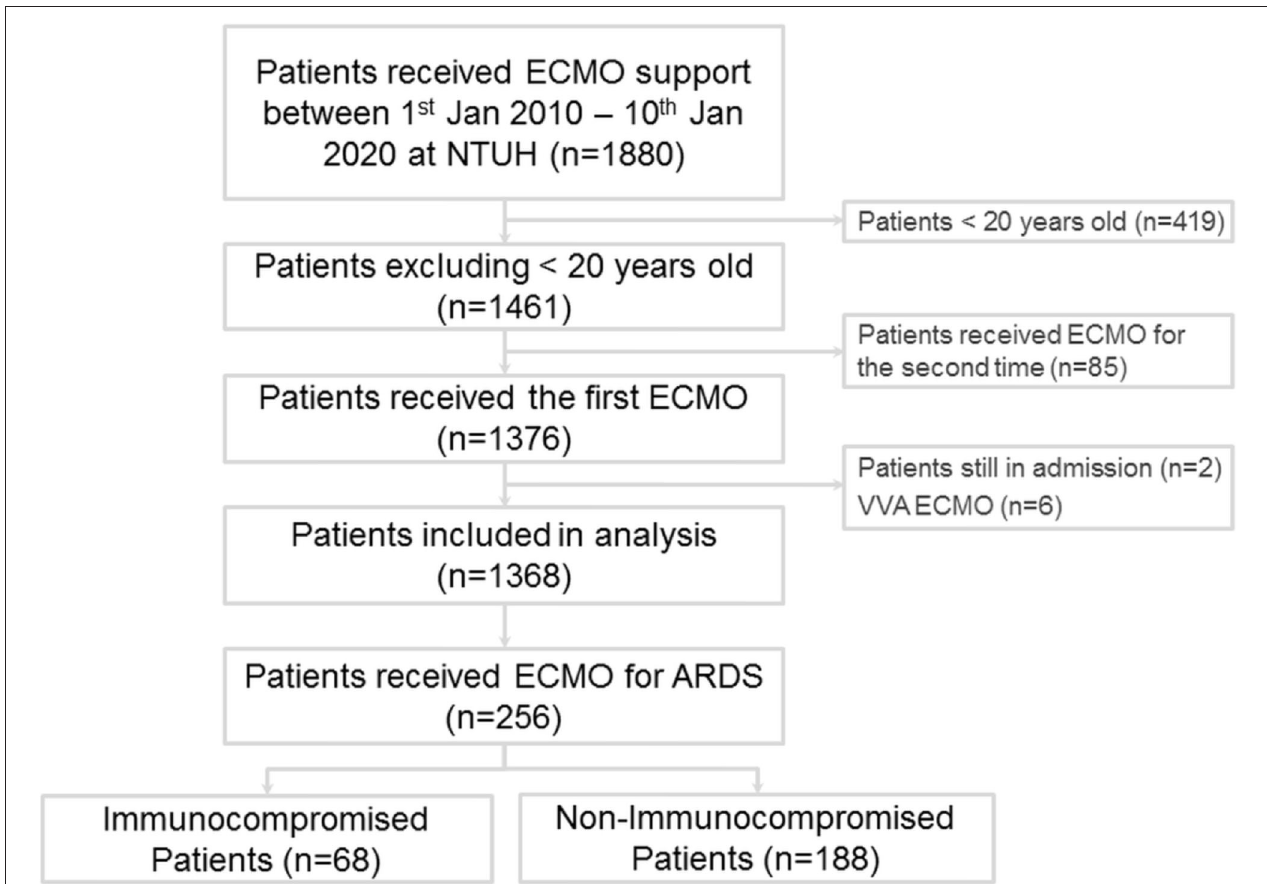
FIGURE 1 | Flow diagram of patients with acute respiratory distress syndrome treated by extracorporeal membrane oxygenation.